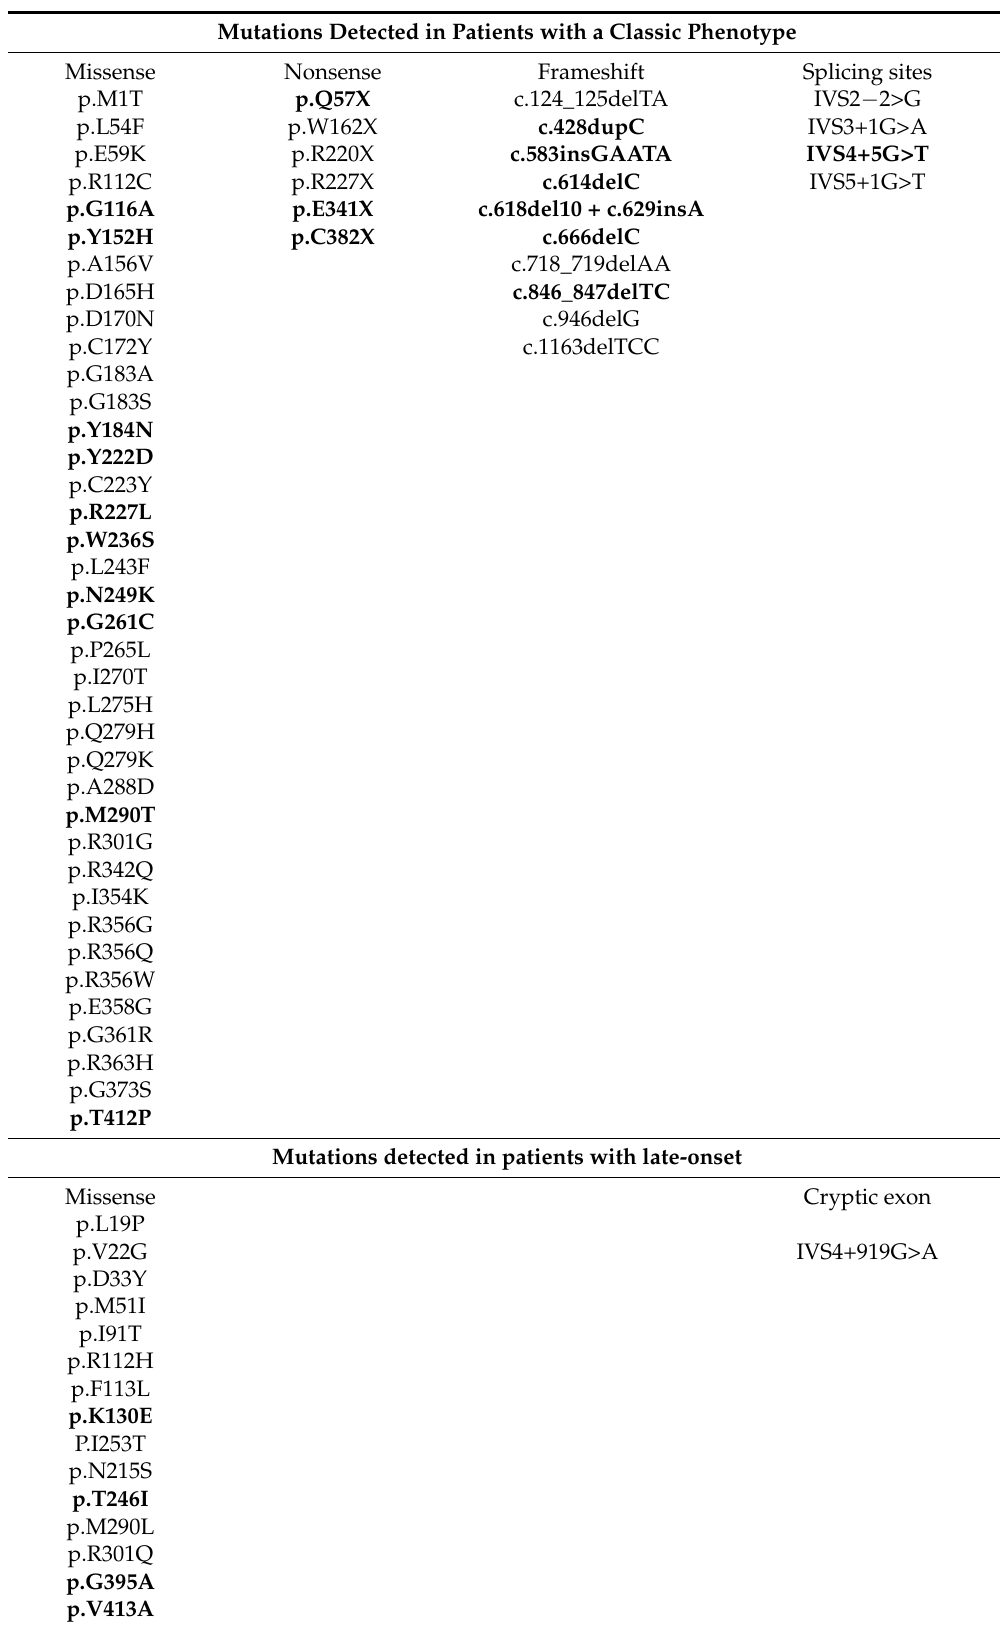
Table 2. Mutations detected in our study, divided by classes according to the phenotype observed in patients in whom they were identified. Mutations in bold were described by us for the first time